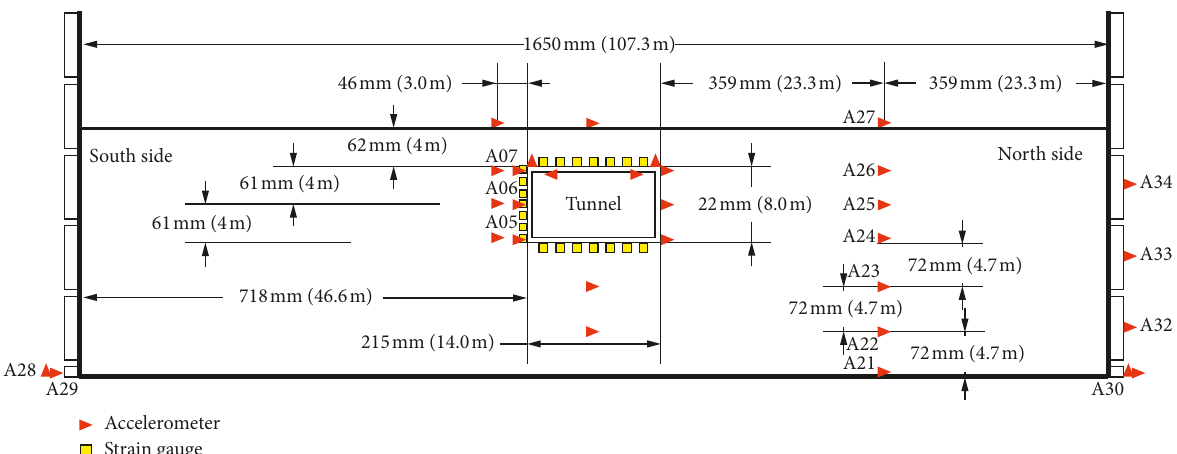
Figure 3: Centrifuge instrumentation layout indicating the accelerometers and strain gauge locations